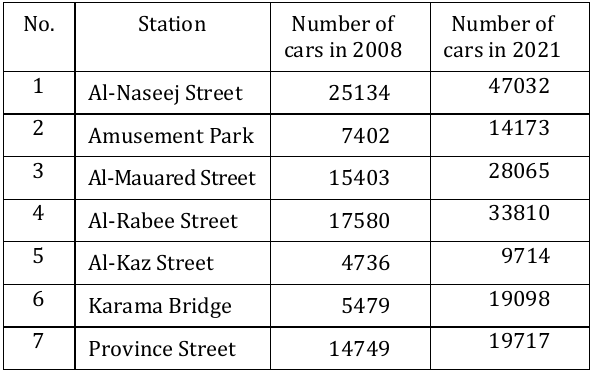
Fig. 9. Traffic flow (car/day) in the streets surrounding the study area in 2008 and 2021 Table 1. Traffic flow (car / day) in the streets surrounding the study area in 2008 and 2021 (Source: Urban Planning Directorate in